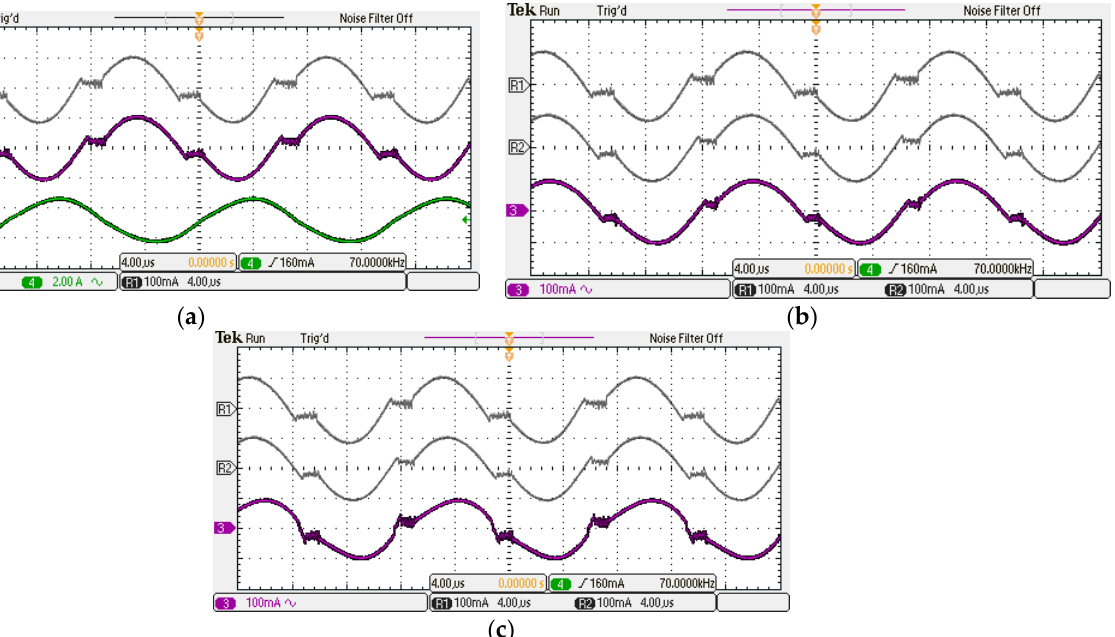
Figure 20. TR2 current measurements: ( a ) I pri as green (4); I sec 1 as gray (R1); I sec 20 as purple (3); ( b ) I sec 1 as gray (R1); I sec 20 as gray (R2); I sec 10 as purple (3); ( c ) I sec 1 as gray (R1); I sec 20 as gray (R2); I sec 4 as purple (3). Table 5. OVD, VDE measurements and calculations. Layer